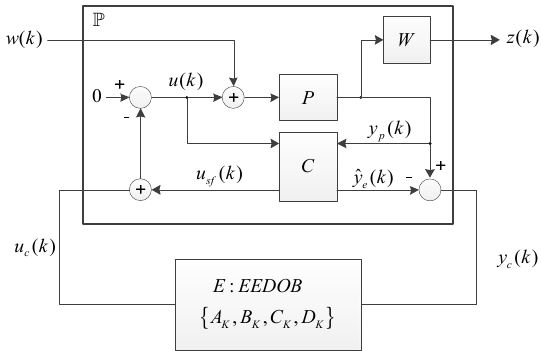
Figure 7. Design frame work of the proposed EEDOB.